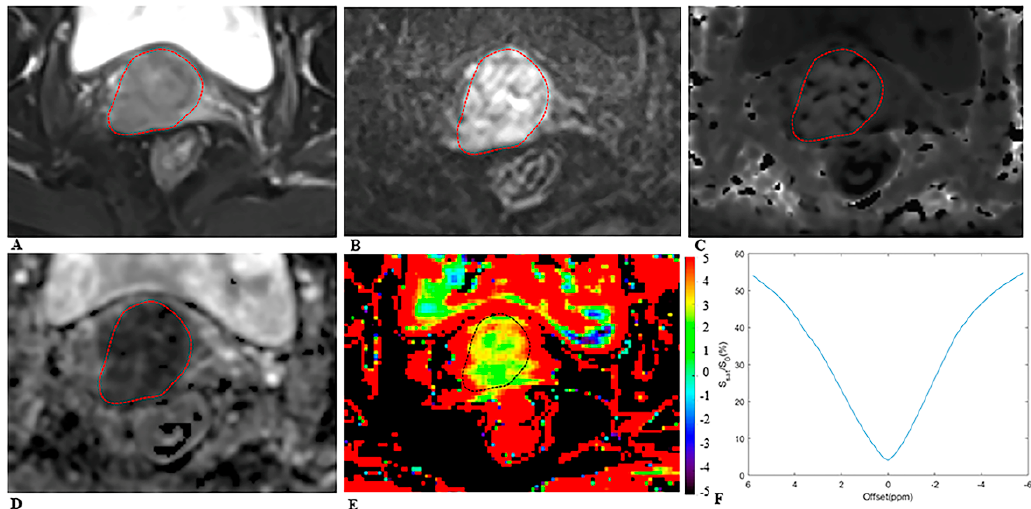
Figure 2. MRI scans in a 64 − year − old woman with cervical cancer and postoperative pathology revealed LNM. Axial ( A ) T2 − weighted image illustrates an exophytic tumor on the cervix wall. A diffusion − weighted image ( B ) with b = 1000 s/mm 2 shows a high − signal − intensity tumor. Mean kurtosis (MK) map ( C ) and mean diffusivity (MD) map ( D ) generated from DKI model. Amide proton transfer − weighted (APTw) image ( E ) and Z − spectrum of the tumor ( F ); the color bar indicates the APTw value. The mean MK, MD, and APTw values measured by the two radiologists were 1.116, 0.774 × 10 − 3 mm 2 /s, and 4.5%, respectively.